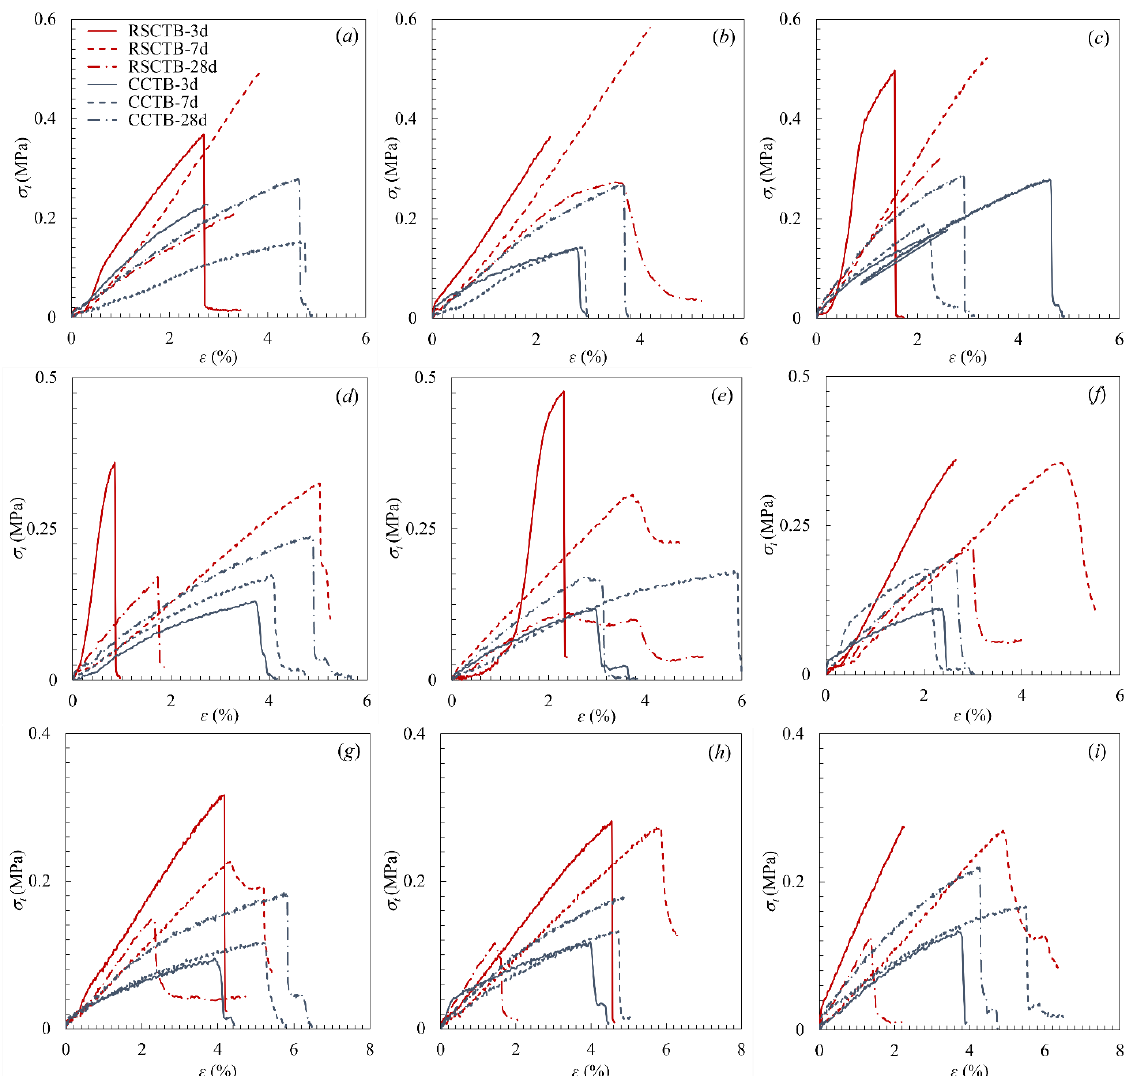
Figure 4. Stress–strain curves obtained from the Brazilian tests. ( a – i ) represent nine formulas in Table 4 respectively.